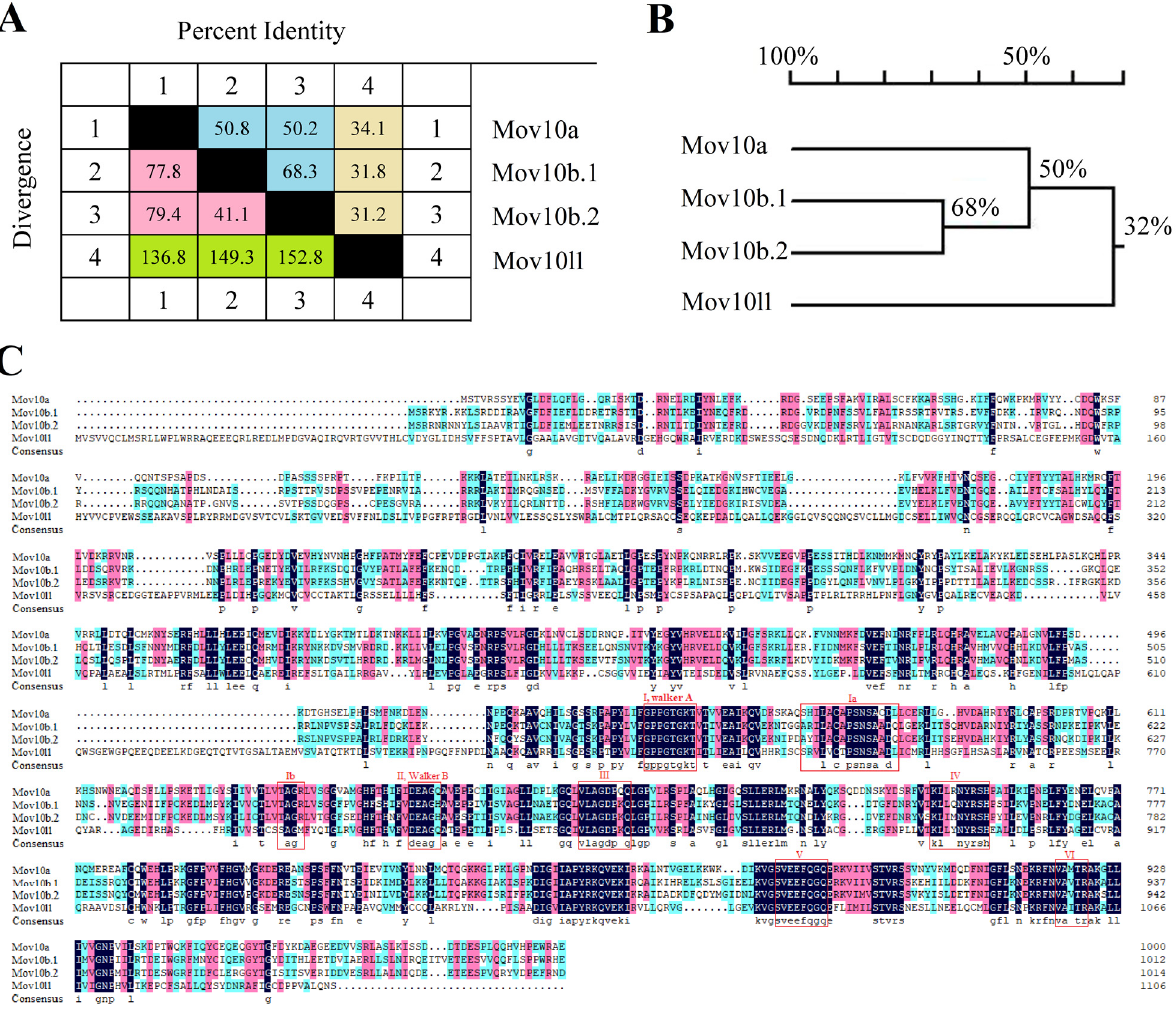
Figure 1. The protein sequences alignment of the Mov10s and Mov10l1 in zebrafish. ( A ) The percent identity and divergence of Mov10s and Mov10l1. The blue and pink areas, respectively, represent the percent identity and divergence between the three Mov10s, and the yellow and green areas show the percentage between either of Mov10s and Mov10l1. ( B ) The phylogenetic tree of Mov10s and Mov10l1. Numbers at each branches mean the percentage of their similarity. ( C ) The sequences alignment of Mov10s and Mov10l1. The dark blue area means 100% similarity; pale red, 75%; light blue, 50%; colorless, 0. The red boxes represents conserved sequences from previous studies.